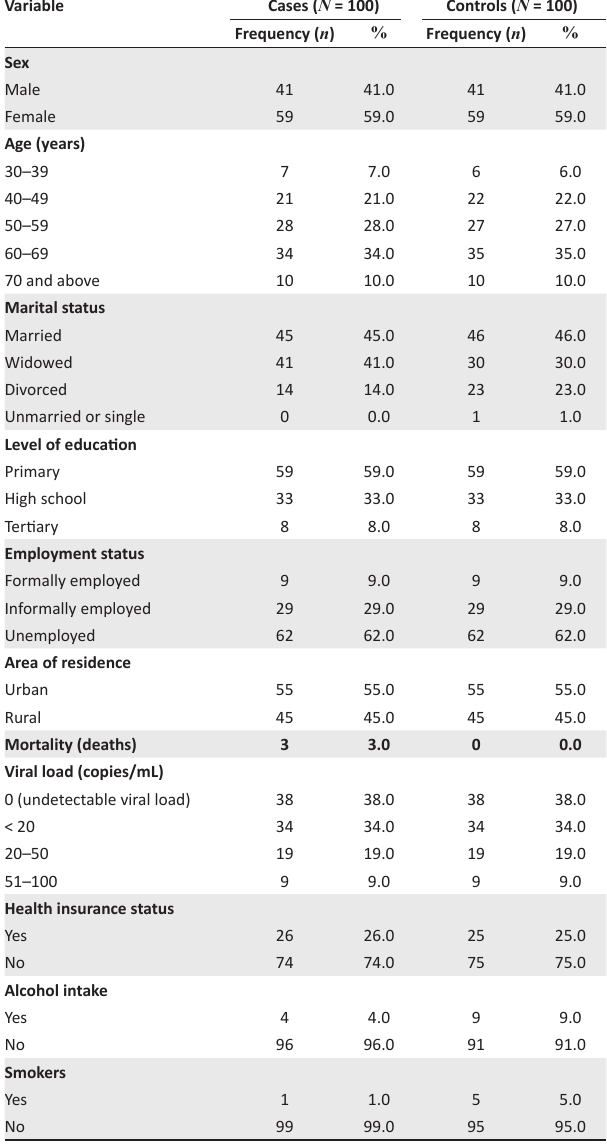
TABLE 1: Baseline demographic study